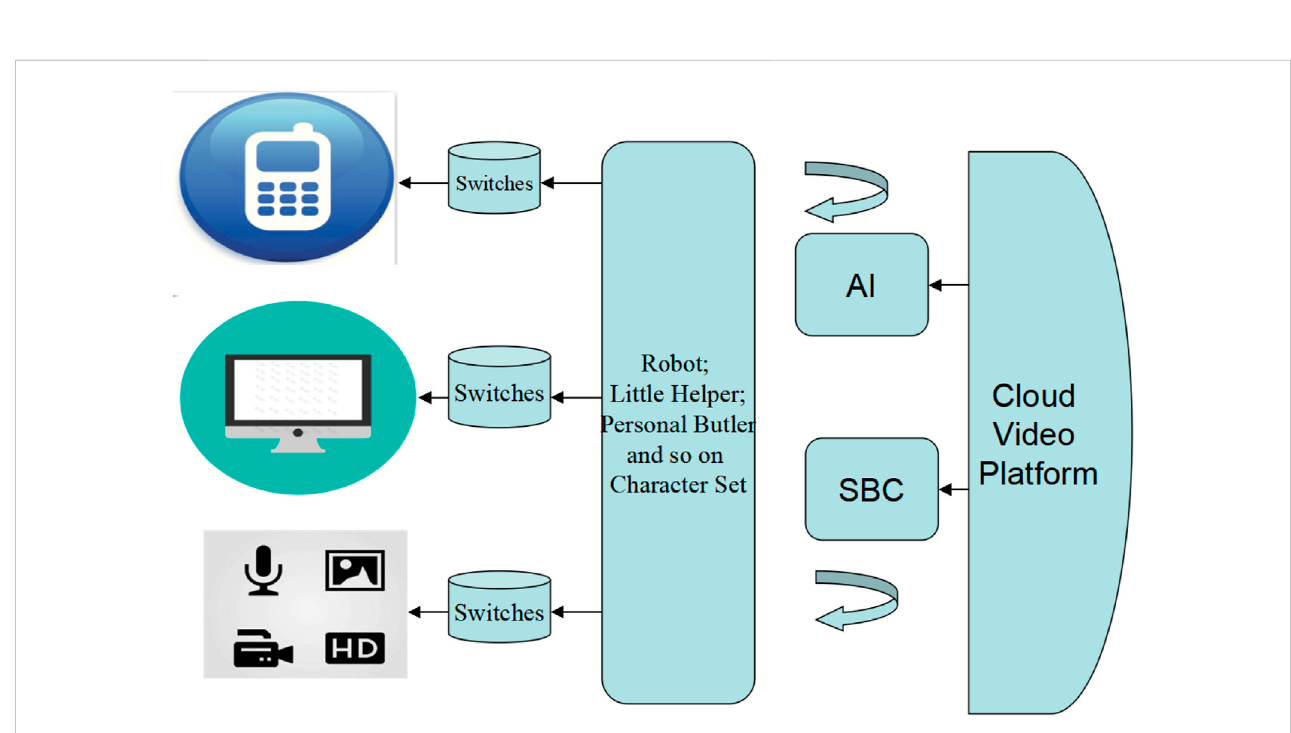
FIGURE 6 Cloud video